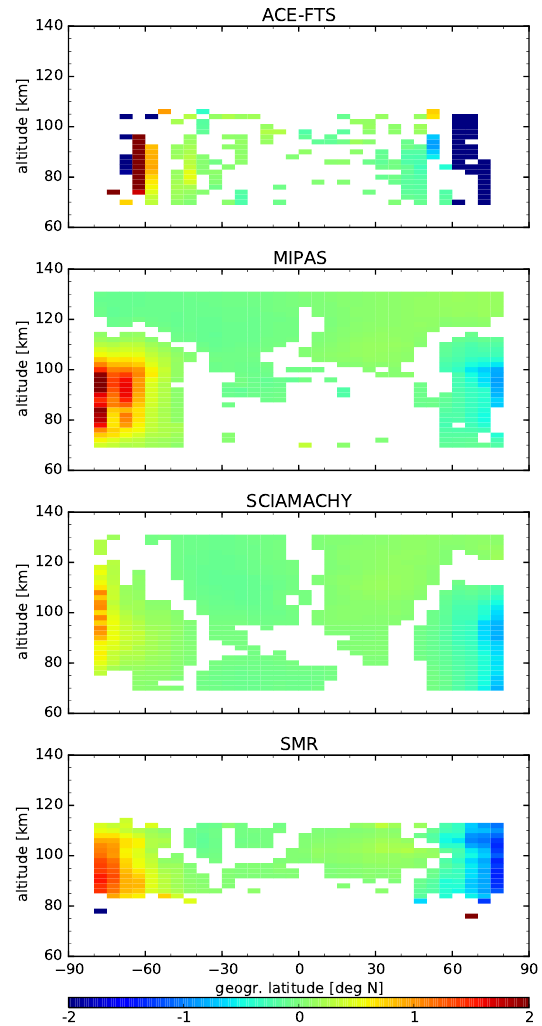
Figure 15. NO mean residuals of the individual measurements to the composite fit. Shown are the values where the regression fit is above the 95% significance level determined using the F test.